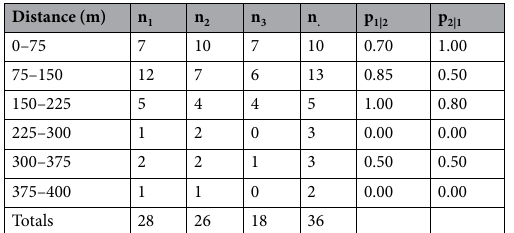
Table 1. Summary statistics from the Mark-Recapture Distance Sampling analysis of dolphin data: n 1,2 is the number of detections made by observers 1 and 2, respectively; n 3 is the number of duplicate sightings; n . is the total number seen, calculated as n 1 + n 2 – n 3 ; and the p s are the conditional detection probabilities. Results are broken down into 75 m distance bins away from the transect